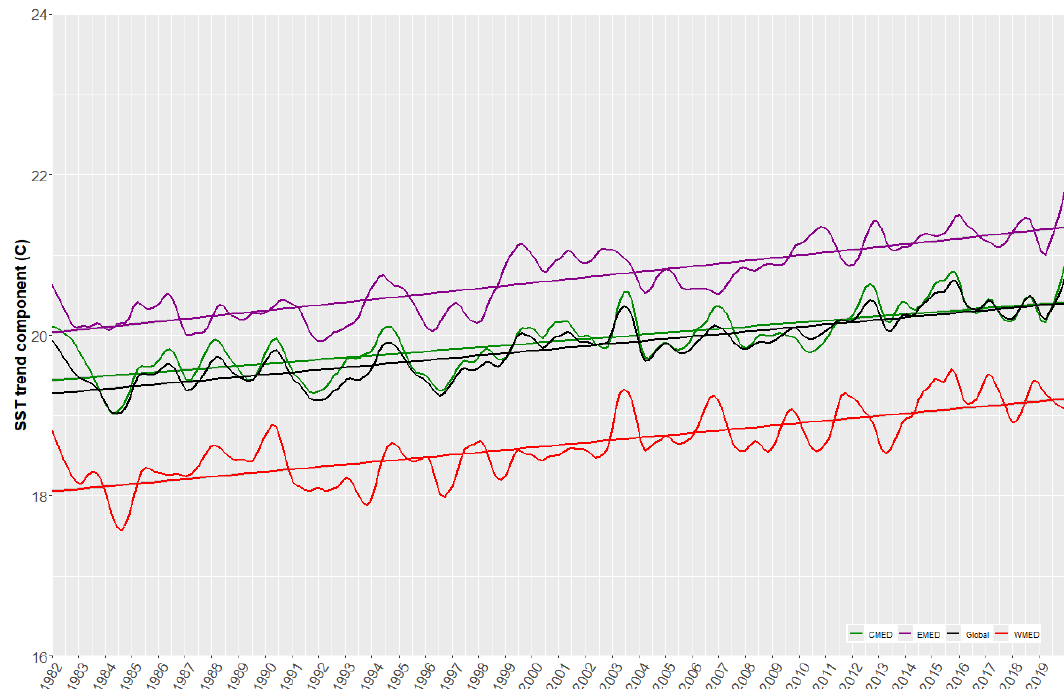
Figure 5. Deseasonalized SST trend component and linear regression (at 99% confidence level) for 1982–2019 for the global Mediterranean basin (black), WMED (red), CMED (green) and EMED (magenta).